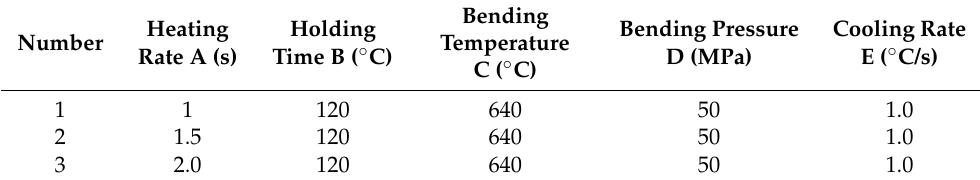
Table 3. Parameter setting of heating rate.